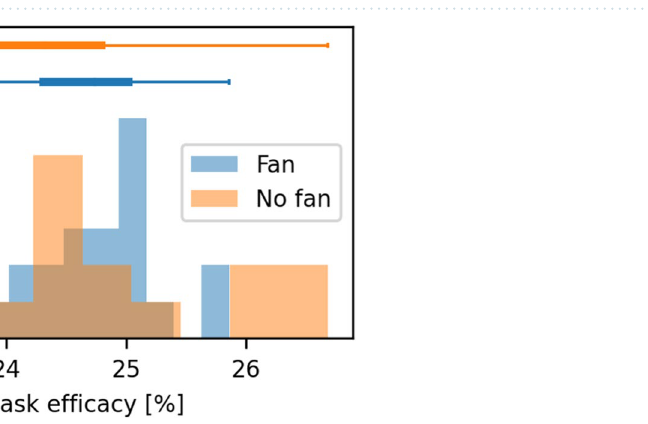
Figure 6. Efficacy of a single FFP2 mask as a function of surrounding aerosol concentration. Five measurements (trials 1 to 5) were made. One trial consists of multiple measurements at increasing concentrations. The concentrations were increased by simply generating aerosols for a longer period. The brackets show the 95% confidence intervals of 100 data points. Although there seems to be a slight reduction in efficacy at higher concentrations, the overall effect is very small, and the efficacy is nearly constant at all concentrations. Very similar trends were observed with surgical masks (not shown).